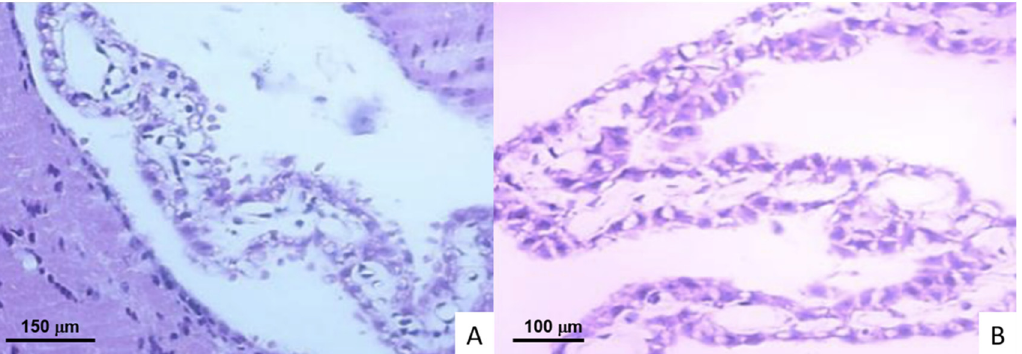
Figure 2. Histological micrographs of Balb/C mice choroid plexus. ( A ) 28 and ( B ) 60 DPI with M. tuberculosis H37Rv ependymal cells with inflammatory characteristics, cytoplasmic vacuolation, and architectural distortion (400× and 600× magnification, respectively).